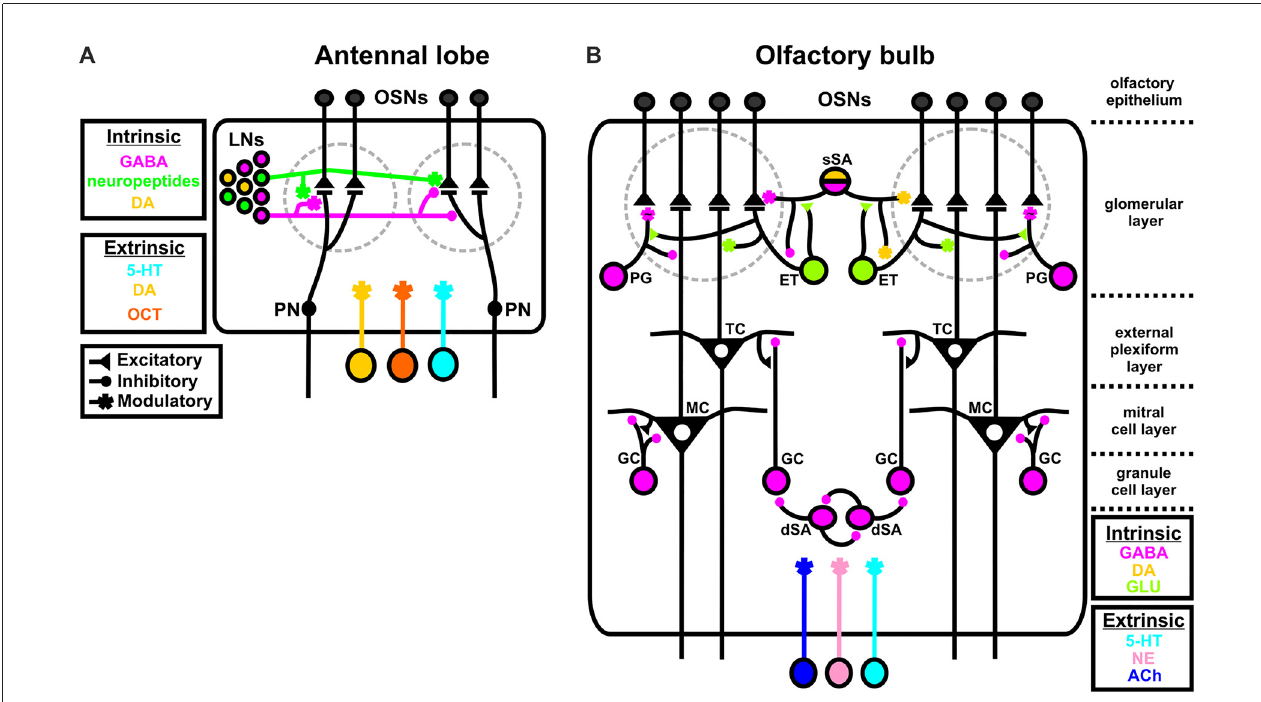
FIGURE 1 | Intrinsic and extrinsic sources of neuromodulation in the insect and vertebrate olfactory system. (A) In the insect antennal lobe (AL), all three principal neuron types, olfactory sensory neurons (OSNs), local interneurons (LNs), and projection neurons (PNs) are subject to both intrinsic and extrinsic sources of modulation. GABA (magenta), dopamine (DA; yellow), and a suite of neuropeptides (green) released by LNs act as intrinsic modulators, while serotonin (5-HT; blue), DA, and octopamine (OCT; orange) act as extrinsic modulators to contextually alter olfactory processing. DA can be extrinsic or intrinsic depending on the species. (B) In the vertebrate olfactory bulb (OB), subtypes of LNs broadly serve as sources of intrinsic modulation. GABAergic periglomerular cells (PG), glutamatergic external tufted cells (ET; light green) and GABAergic/DAergic superficial short axon cells (sSA; magenta/yellow) synapse onto OSNs, mitral and tufted cells (M/Ts) and each other in the glomerular layer. GABAergic granule cells (GC) synapse onto M/Ts to alter OB output and GABAergic deep short axon cells (dSA) both reciprocally synapse onto themselves and GCs. Both the AL and OB are innervated by extrinsic sources of 5-HT, norephinephrine (NE; pink), and acetylcholine (ACh; dark purple). The “ ∼ ” symbol at the PG to OSN synapse indicates that this is a non-traditional synapse that depends upon GABA spillover.